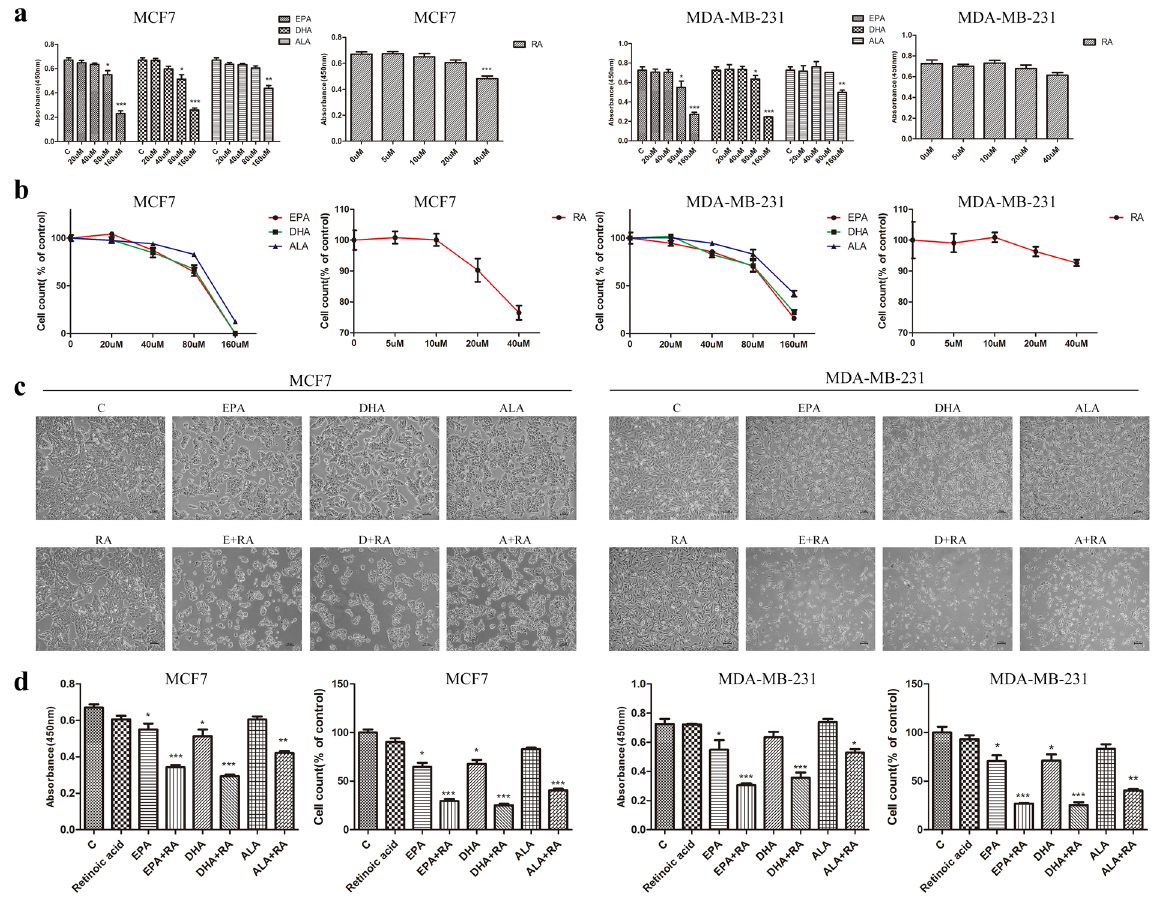
Figure 1. Cell growth. MCF7 and MDA-MB-231 cells were treated with different concentrations ω -3 FFAs and ATRA for 72 h. CCK8 assays ( a ) and Cell counting assays ( b ). The inhibitory effects of combined treatment with 80 μ M ω - 3 FFAs and 20 μ M ATRA on MCF7 and MDA-MB-231. Cell morphology ( c ), CCK8 assays and